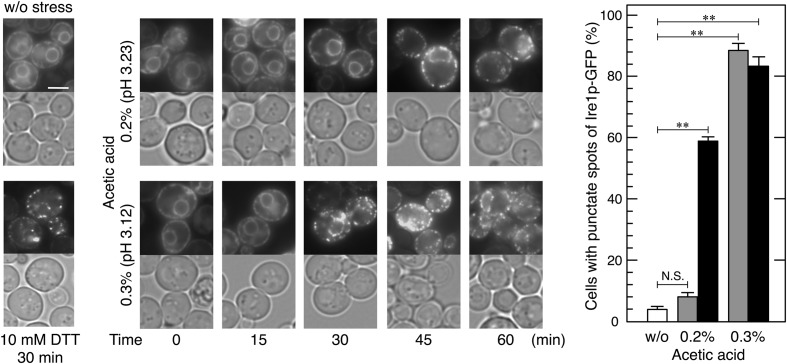
Changes in the localization of Ire1p-GFP upon acetic acid stress. Exponentially growing cells were exposed to the indicated conditions. Ire1p-GFP was immediately observed after the treatment. Representative pictures are shown. (Upper), Ire1p-GFP; (Bottom), bright field. The white bar indicates 3 μm. Quantitative data are shown as means ± standard error. One hundred cells under each condition were examined and experiments were repeated three times (300 cells in total were examined). Cells were treated with acetic acid for 30 min (gray bars) or 60 min (black bars). ∗∗P-value < 0.01. N.S., no statistically significant difference.